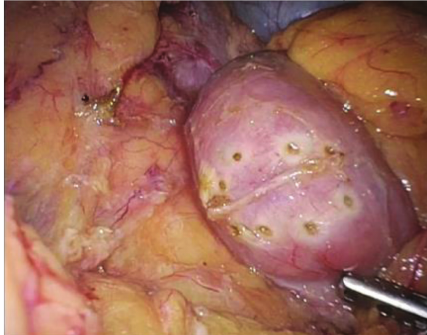
Figure 2: Laparoscopic view of intentional perforated peripheral marking. Under laparoscopic supervision, endoscopist penetrates the duodenal wall intentionally along the borderline of the lesion. Then, surgeon can identify the peripheral margin of the lesion under laparoscopic view.